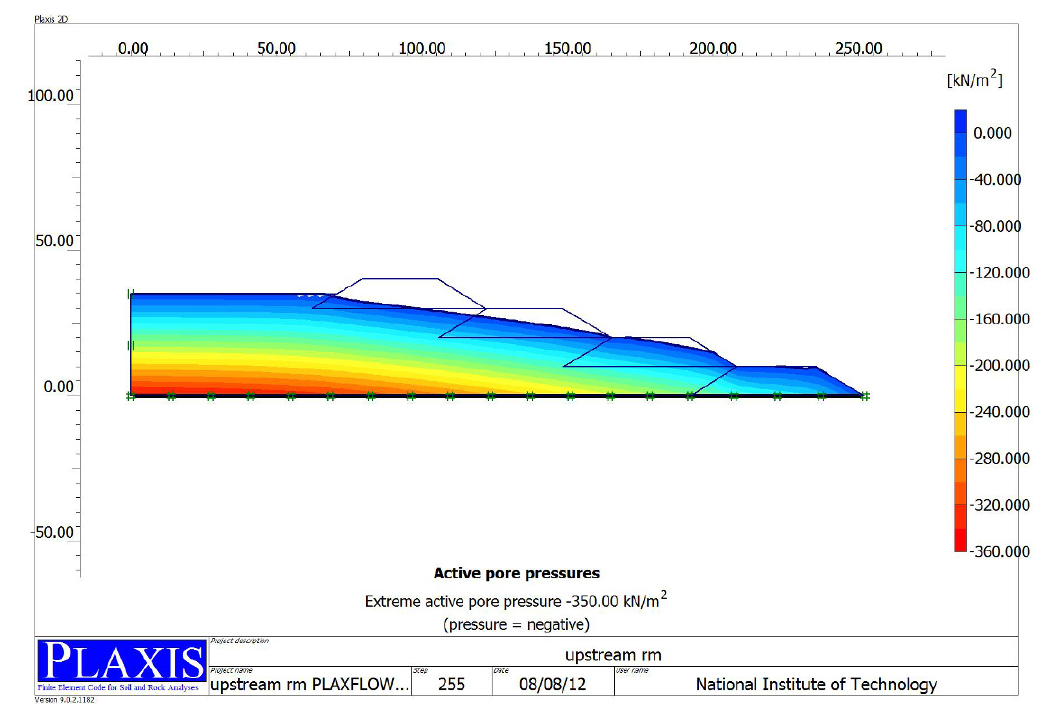
Figure 10. Active pore pressure diagram of upstream method dam